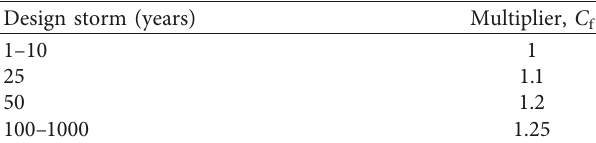
Table 1: Frequency factors for the rational method. Design storm (years) Multiplier, C